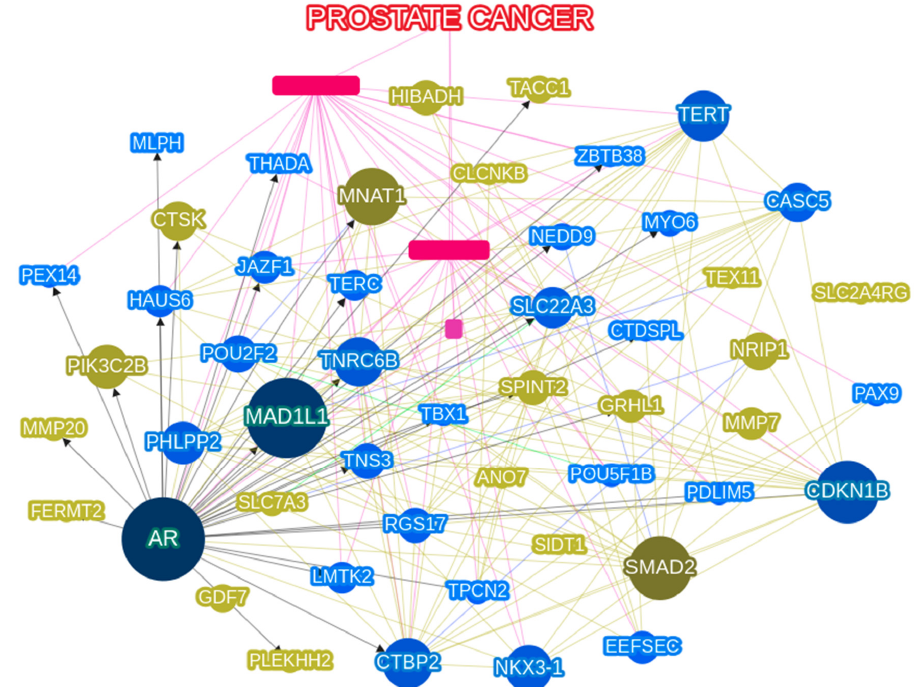
Figure 5. Network analysis of prostate cancer (PCa)-related single nucleotide polymorphisms (SNPs), for log-adjusted p -value of Fisher’s exact test in |AFR| + |EAS|) with a cutoff over 60. The most relevant genes are AR (Androgen Receptor), MAD1L1 (Mitotic Arrest Deficient 1 Like 1), and CDKN1B (Cyclin Dependent Kinase Inhibitor 1B). The dark blue circles are the seed gene, and the light blue are genes interacting with the seed gene. The army green circles connected to the seed genes are the protein-protein interactions. Detailed legend information is provided in https://phenolyzer.wglab.org/download/Phenolyzer_manual.pdf (accessed on 1 December 2021).